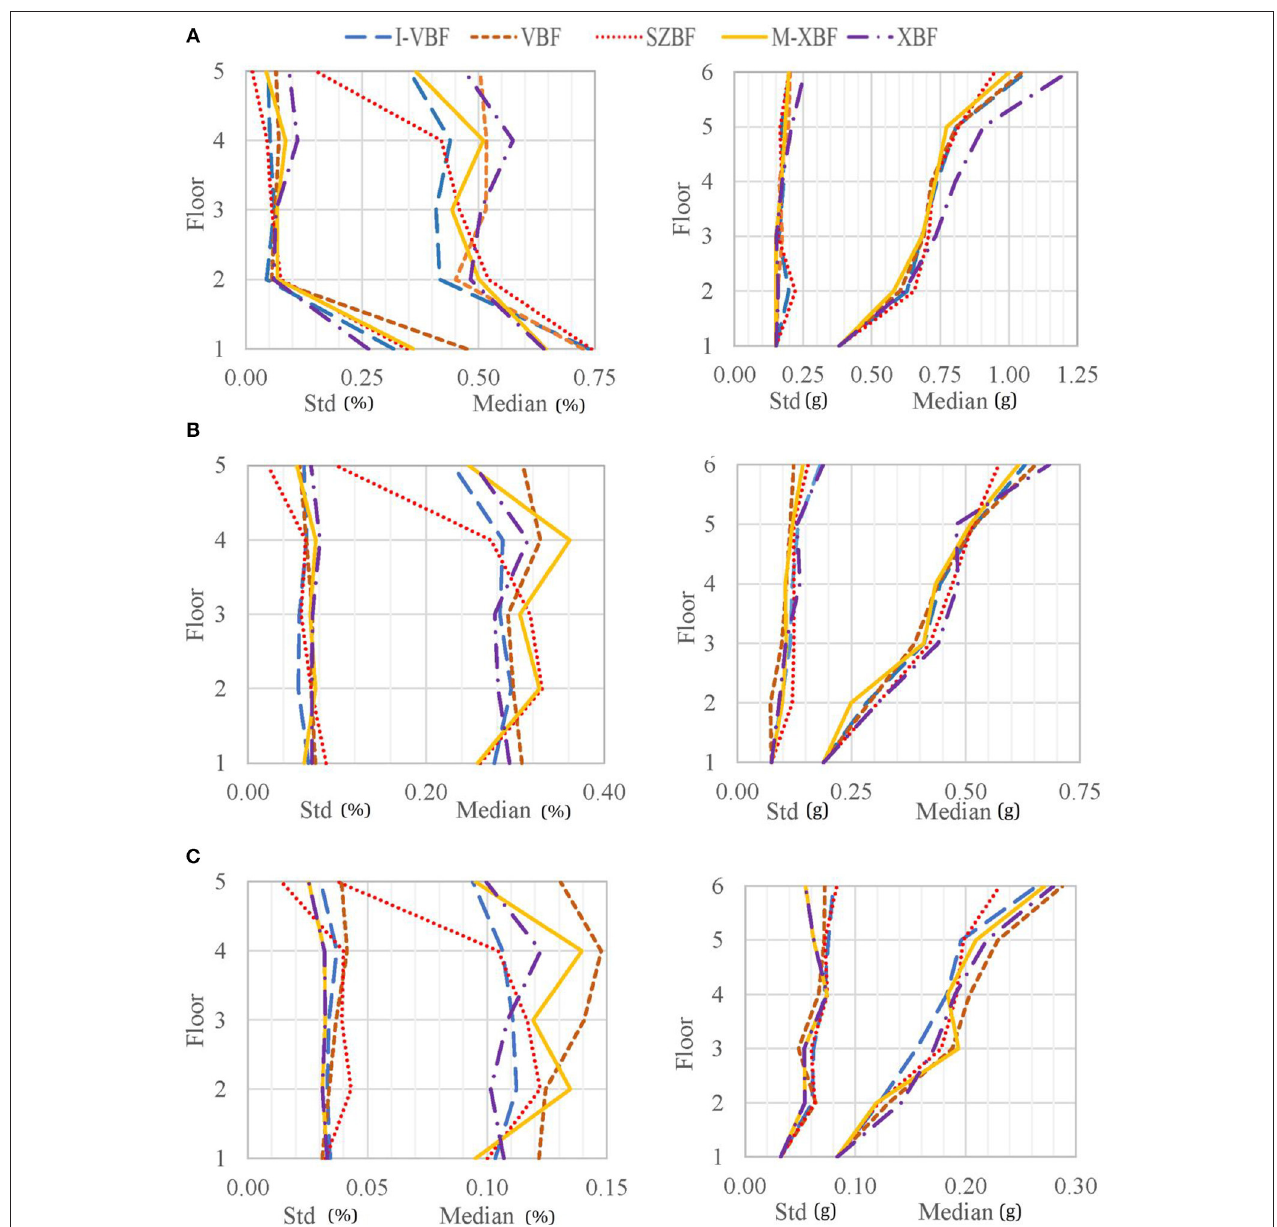
FIGURE 6 | Median peak inter story drift ratio and its corresponding standard deviation in left plots and peak floor acceleration and its corresponding standard deviation in right plots at (A) 2/50 hazard level, (B) 10/50 hazard level, and (C) 40/50 hazard level.